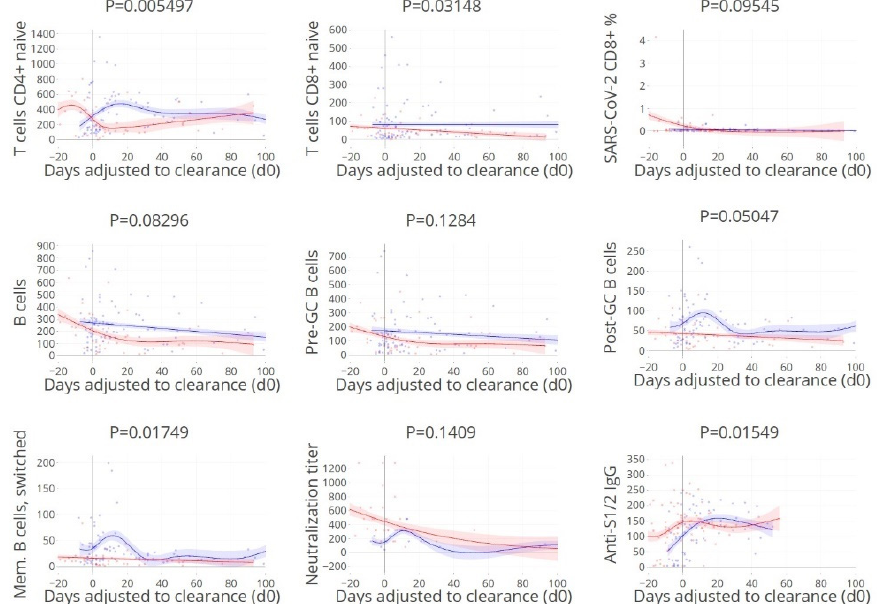
Figure 7. Peak levels of naïve CD4+ T cells, naïve CD8+ T cells, post GC and memory B cells, and anti-spike IgG coincide with rapid viral clearance. Kinetics of humoral and cellular immune parameters adjusted to the timing of viral clearance (day 0). A selection of humoral and cellular parameters was made based on findings described above. Blue: viral clearance ≤ 21 days, red: > 21 days. Lines indicate non-linear group trends. Spline regression with bootstrap confidence intervals.